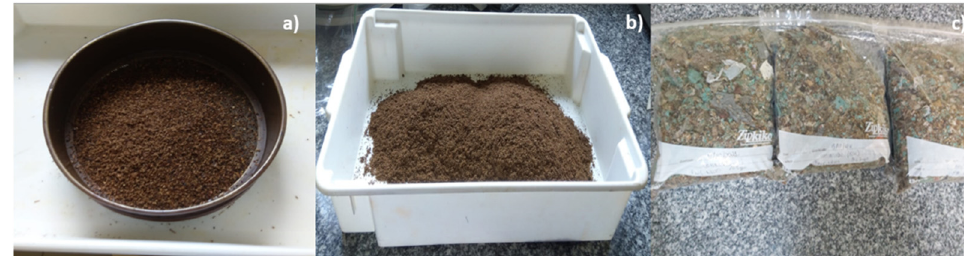
Figure 3. Pre-treated organic matter + paper used as feed material by thermal processing in laboratory scale. Organic matter after crushing and sieving retained over 12 mesh sieve ( a ), organic matter mixed after sieving using 4, 6, 12, and 14 mesh ( b ), organic matter + paper after drying/crushing/sieving packed in plastic bags ( c ).